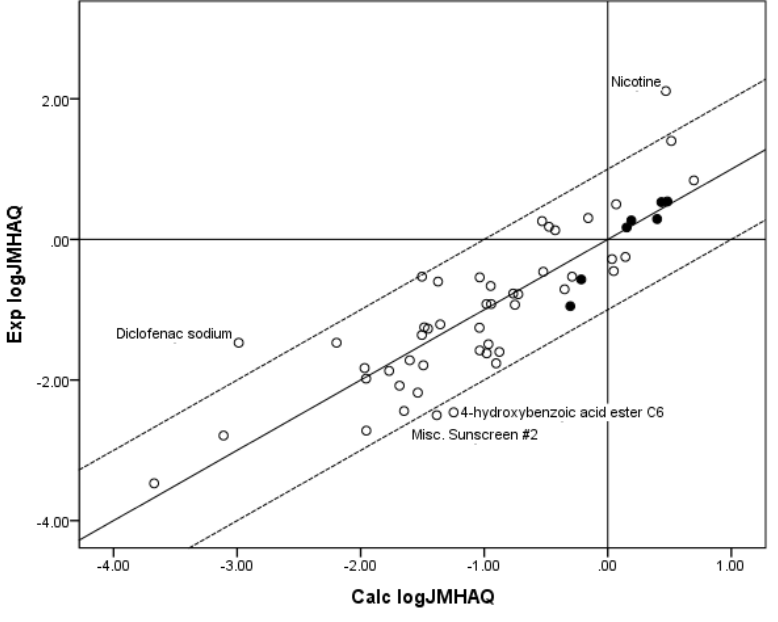
Figure 4. The correlation of the calculated (Calc.) log J from the fit of n = 55 to KSC MHAQ with the experimental (Exp.) log J . The dashed lines represent the boundaries for MHAQ residual Exp. log J greater than 1.0, and the solid line indicates points where the Calc. MHAQ log J is equivalent to the Exp. log J . The filled circles indicate the n = 7 phenols. MHAQ MHAQ The Calc. log J values were determined with Equation MHAQ